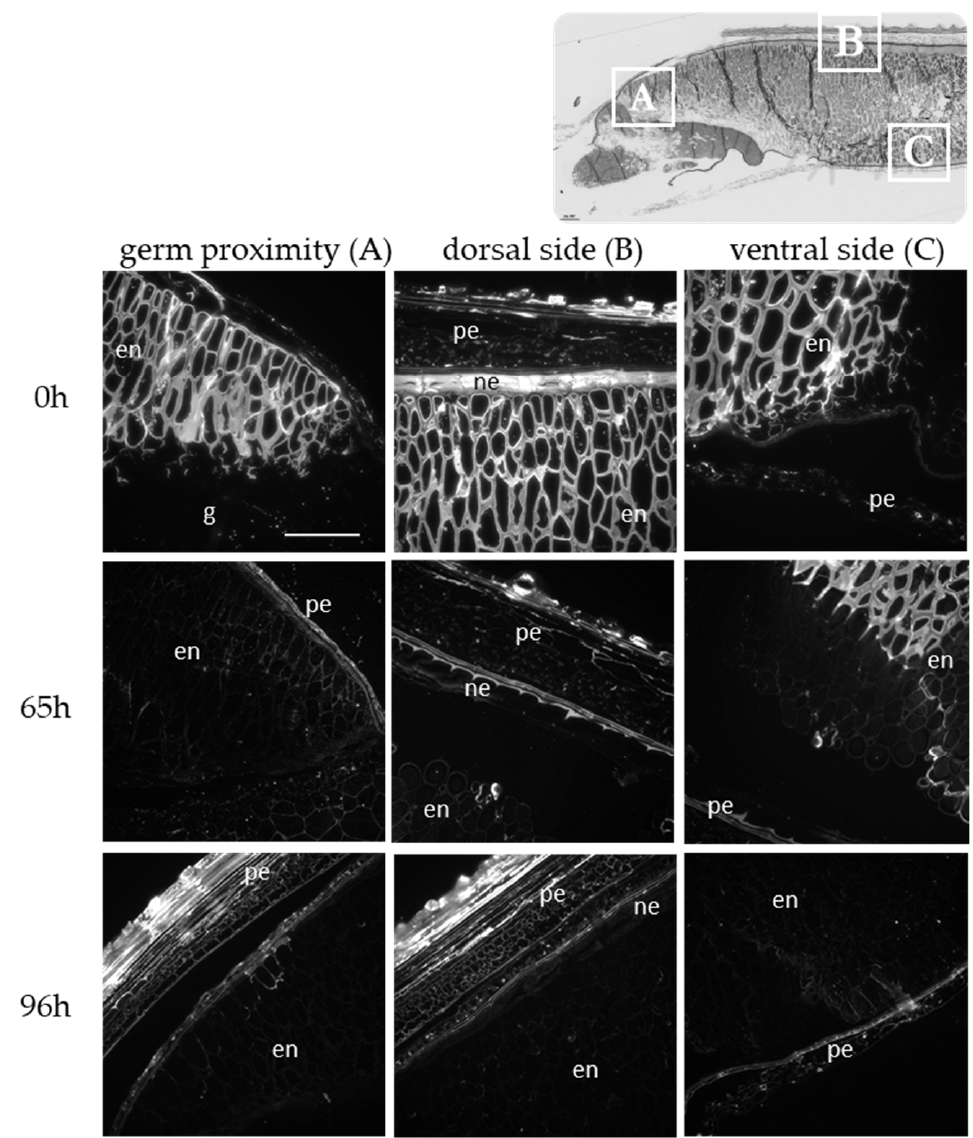
Figure 3. Immunolabeling of germinated grains (0, 65, and 96 h after imbibition) using antibodies specific to MLG. Scale bar = 50 µm. g: germ; pe: pericarp; en: endosperm; ne: nucellar epidermis.